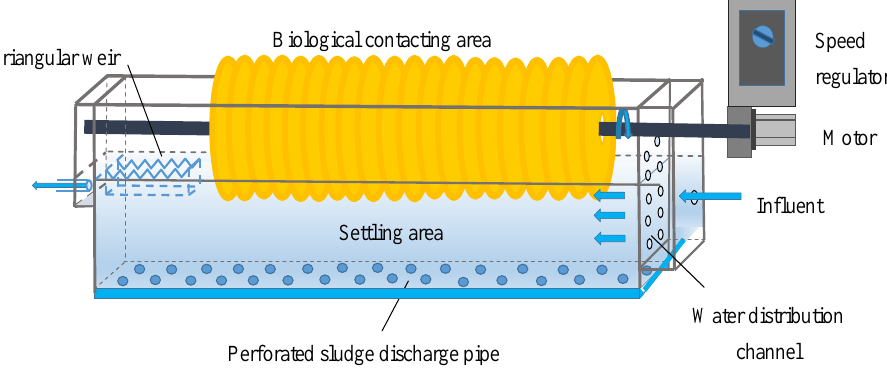
Figure 1. Modified horizontal flow settling tank used in the experiment.